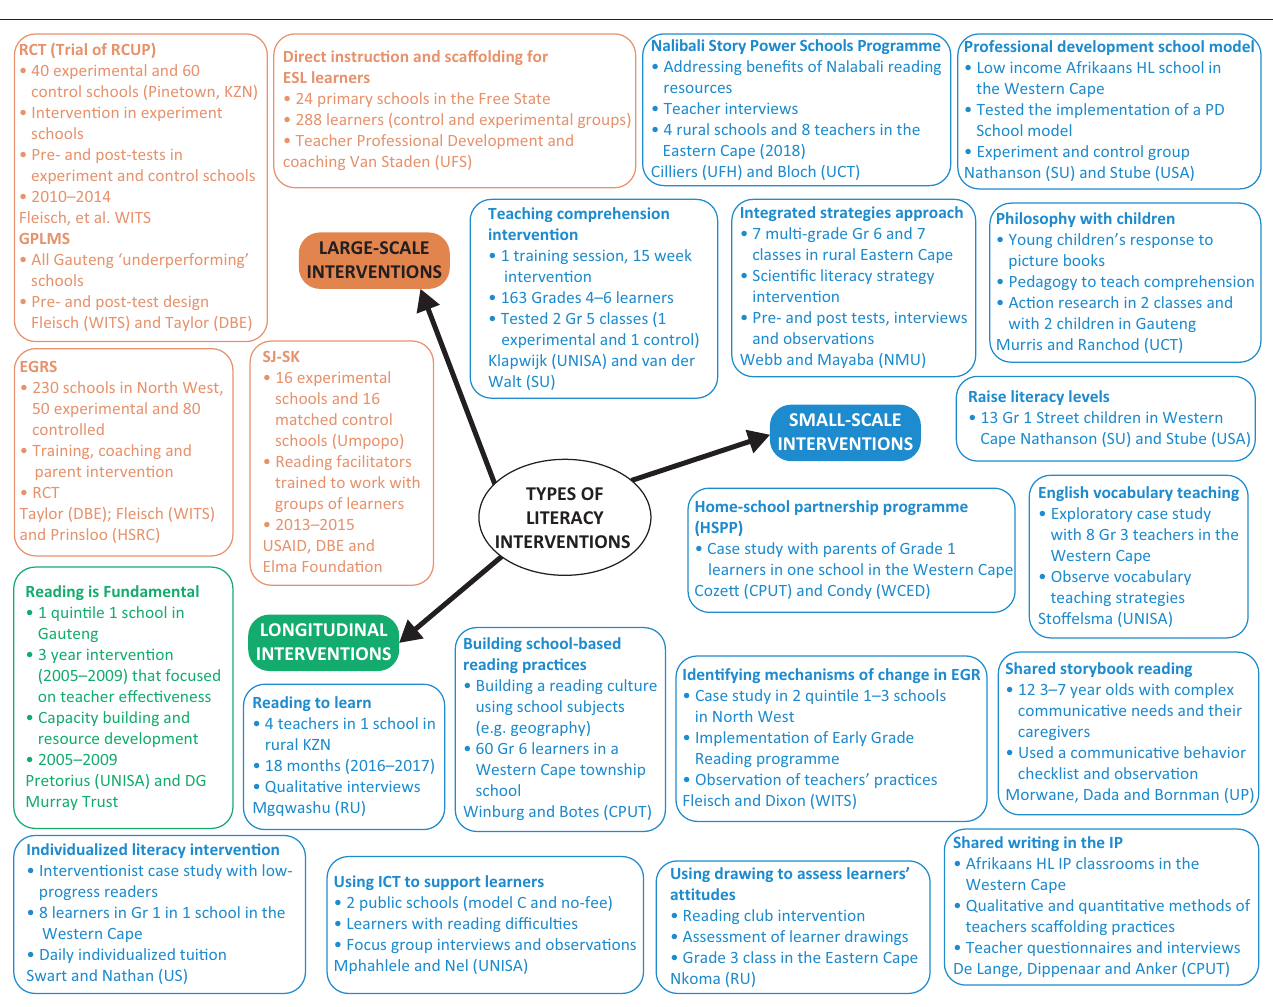
FIGURE 1: Mindmap of literacy interventions